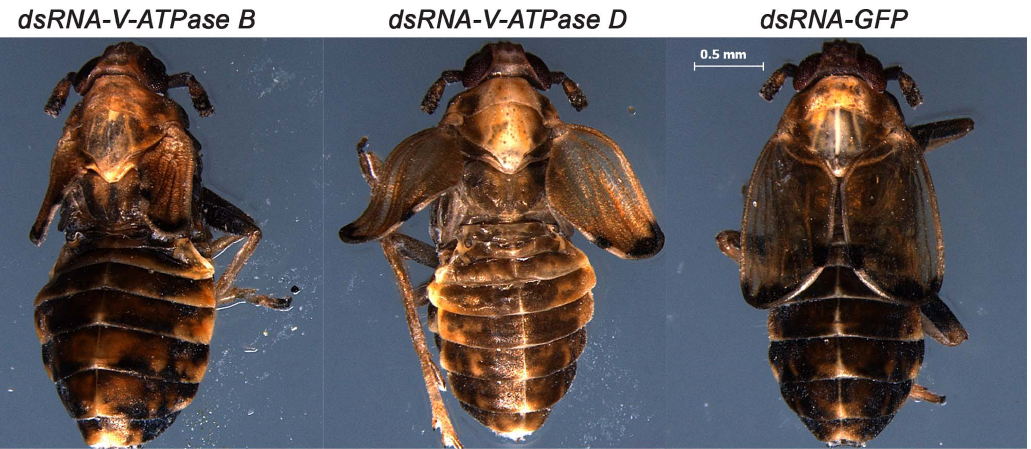
Figure 7. The effect of dsRNA of V-ATPaseB , V-ATPaseD, and GFP on P.maidis development. dsRNA (200 ng) of V-ATPase B , V-ATPase D or GFP was injected into 5 th – stage nymphs. After 10 days, all GFP dsRNA injected insects developed normally, but 90% and 75% of the insects injected with V-ATPase B and V-ATPase D dsRNA, respectively, were deformed. The most obvious deformity was misshapen wings, i.e. , curly and short.